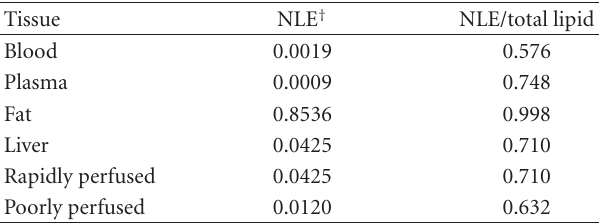
Table 1: Lipid content of rat tissues [11,